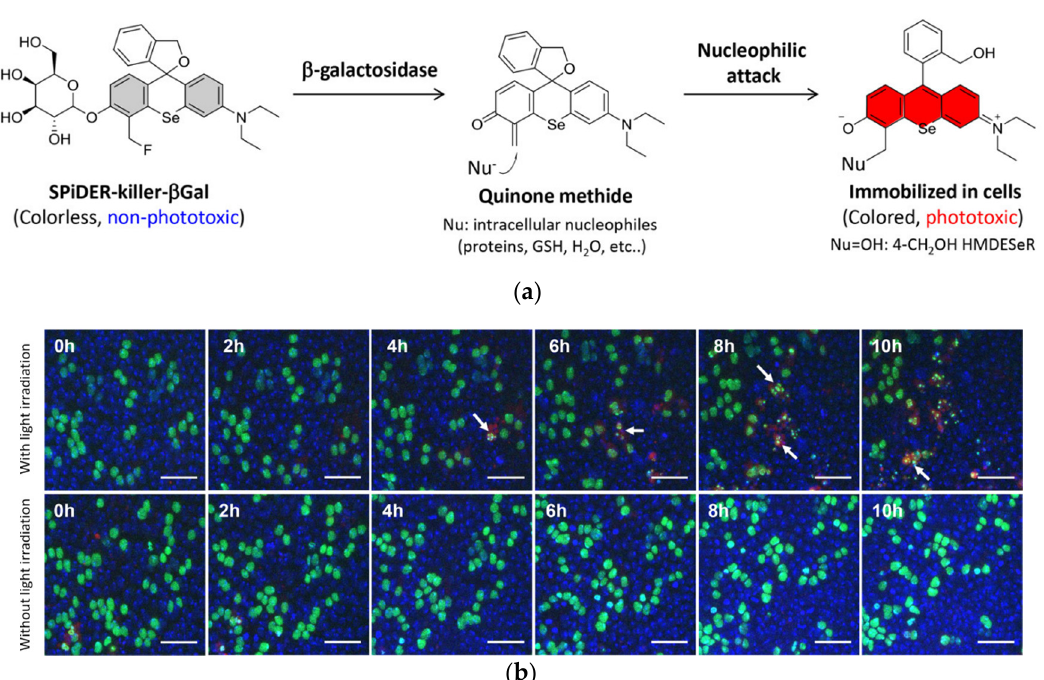
Figure 3. The novel photosensitizer SPiDER-killer- β Gal : ( a ) Photosensitizer activatable by β -galactosidase ( SPiDER-killer- β Gal ), and its reaction scheme with the enzyme; ( b ) Time-lapse in vivo fluorescence imaging of flip-out clones of live pupal notum with (top) and without (bottom) irradiation. Adapted with permission from [103]. Further permissions related to the material excerpted should be directed to the ACS. Scale bars = 30 µm.